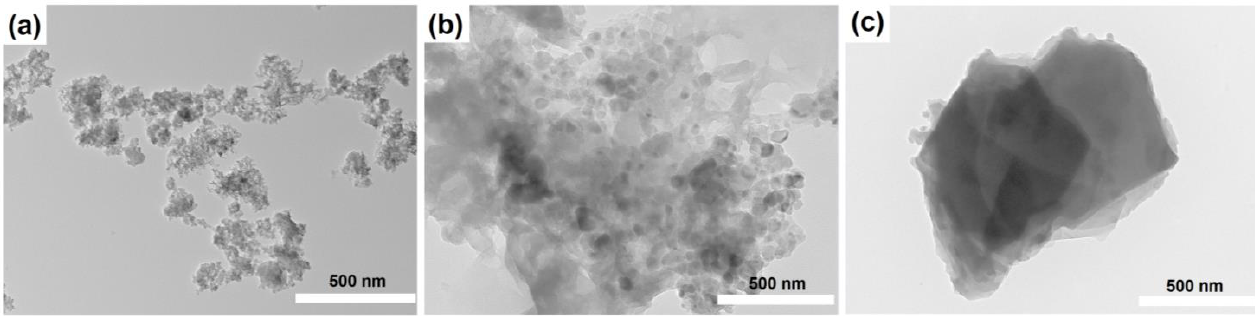
Figure 4. TEM images of intermediate phases: ( a ) Sample IF-iAl-90; ( b ) Sample IF-iAl-130; ( c ) Sample IF-SB-130.